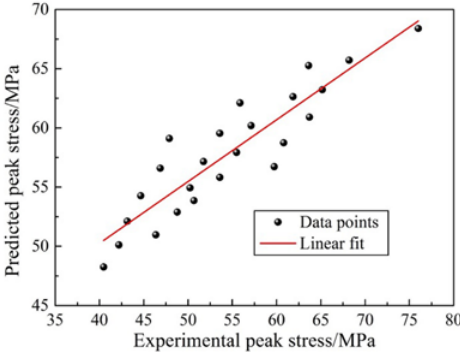
Figure 10. Relationship between predicted peak stress by Arrhenius-type constitutive model and experimental peak stress.